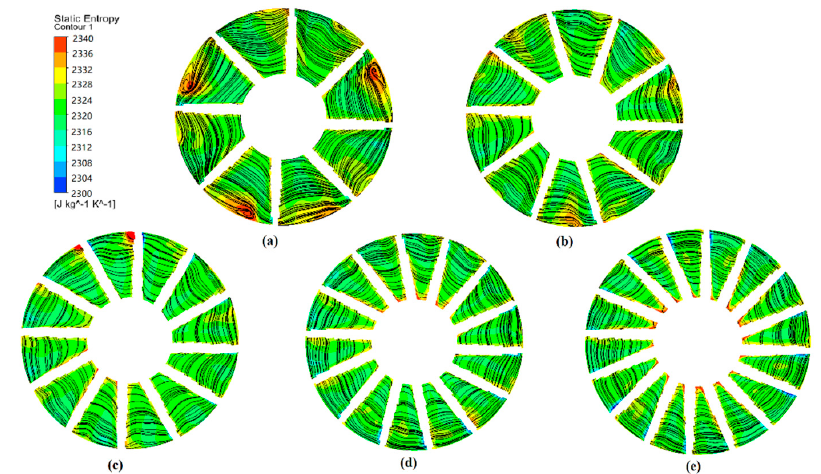
Figure 13. Entropy distribution at outlet with surface streamlines of SCO 2 : ( a ) solidity 7.96; ( b ) solidity 9.95; ( c ) solidity 11.94; ( d ) solidity 13.93; ( e ) solidity 15.92.